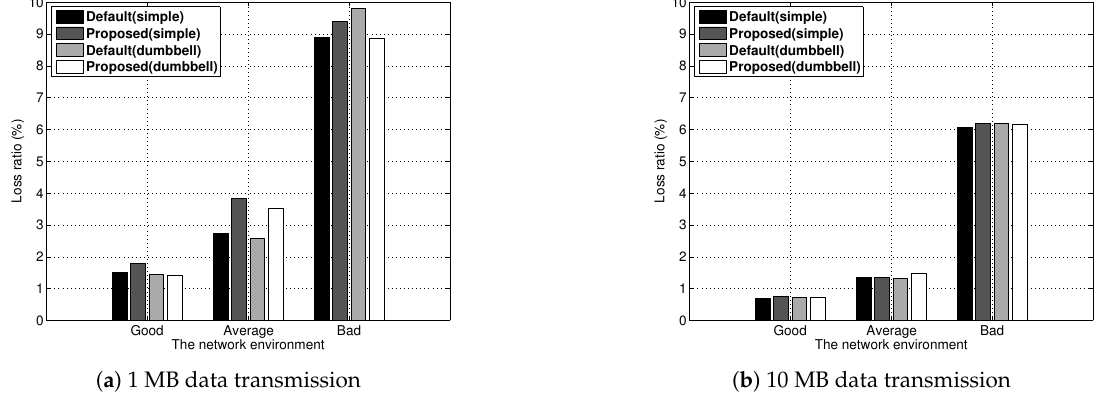
Figure 14. Packet loss ratios for different network conditions. ( a ) 1 MB and ( b ) 10 MB data